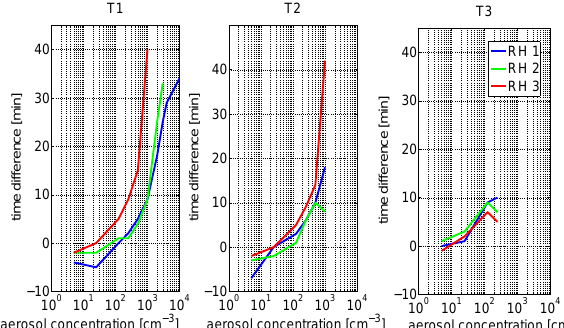
Figure 5. The time difference between the maximum collected mass per unit time and the maximum condensed mass per unit time for each simulated cloud as a function of the aerosol concentration. T1 represents a profile with an inversion layer located at 4km, T2 at 3km, and T3 at 2km. RH1 represents a profile with 95% RH in the cloudy layer, RH2 90%, and RH3 80%. Each curve represents 10 simulations performed for an initialization profile (a total of nine